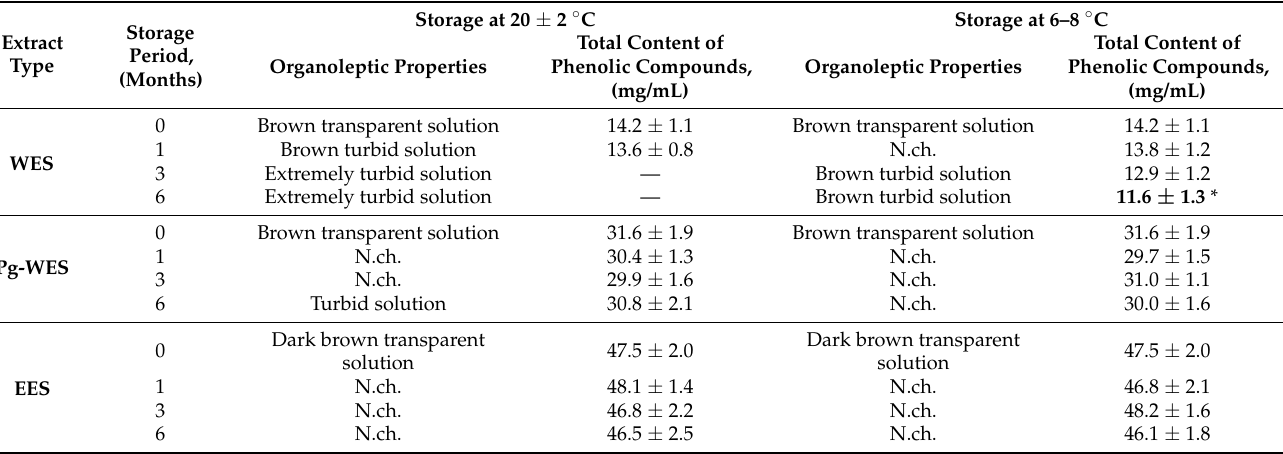
Table 2. The stability of investigated